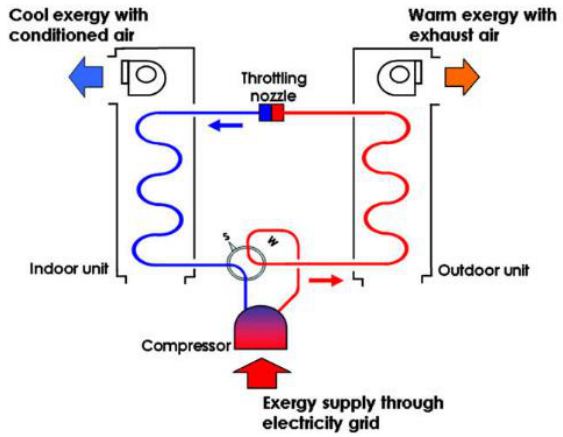
Figure 8. Working principle of an electricity-driven heat pump [31].